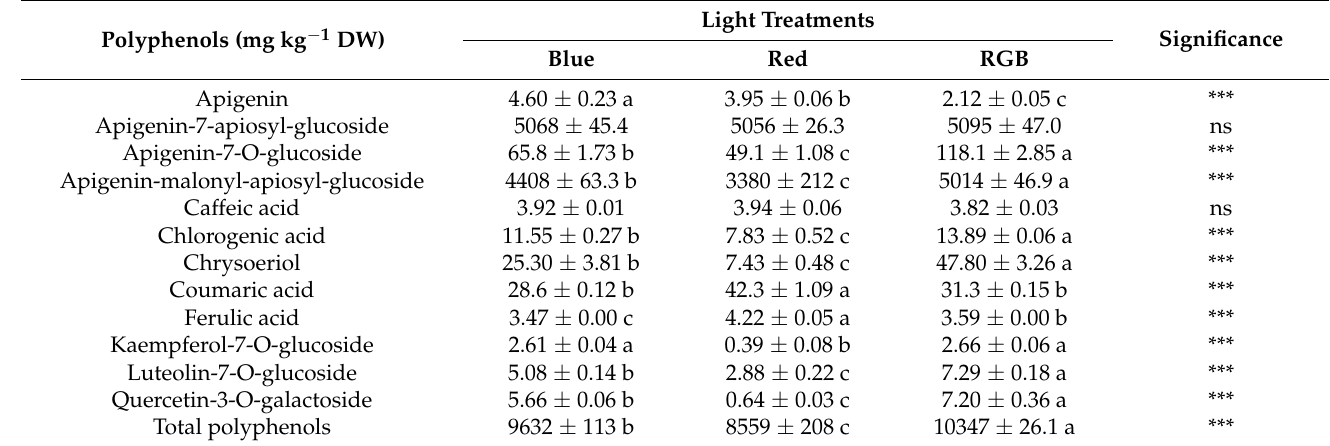
Table 5. Total polyphenols of parsley microgreens with reference to the different light treatments (red, blue and